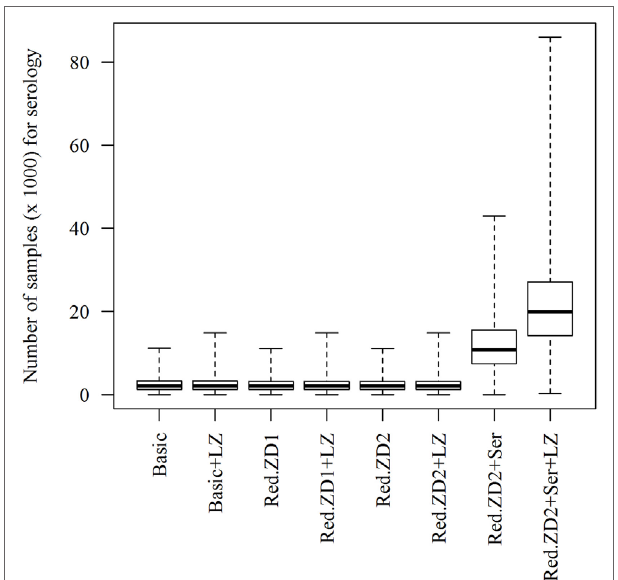
FigUre 1 | Predicted number of samples (animal-samples) for serological testing when different control scenarios against African swine fever-epidemics are simulated. Basic: (1) culling, cleaning, and disinfection of affected herds; (2) 3-day national standstill on animal movements; (3) 3-km protection zone—duration 50 days + 10-km surveillance zone duration 45 days (movements and contact restrictions in zones); and (4) tracing of movements and contacts. Basic + LZ: basic control + surveillance zone 15 km (default: 10 km). Red.ZD1: Basic + duration of protection and surveillance zones 35 days (default: 50 and 45 days). Red.ZD1 + LZ: Red.ZD1 + surveillance zone 15 km (default: 10 km). Red.ZD2: Basic + duration of protection and surveillance zones 35 and 25 days, respectively (default: 50 and 45 days). Red.ZD2 + LZ: Red.ZD2 + surveillance zone 15 km (default 10 km). Red. ZD2 + Ser: Red.ZD2 + serological testing in surveillance zone before lifting the zone (default: clinical surveillance). Red.ZD2 + Ser + LZ: Red. ZD2 + Ser + surveillance zone 15 km (default: 10